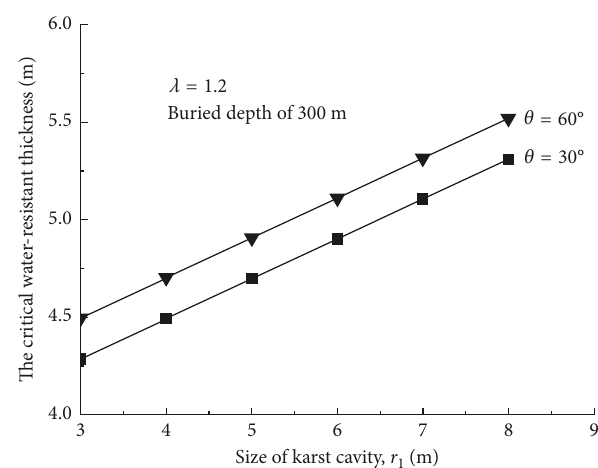
Figure 6: Relationship between the critical water-resistant thick- ness and size of the karst